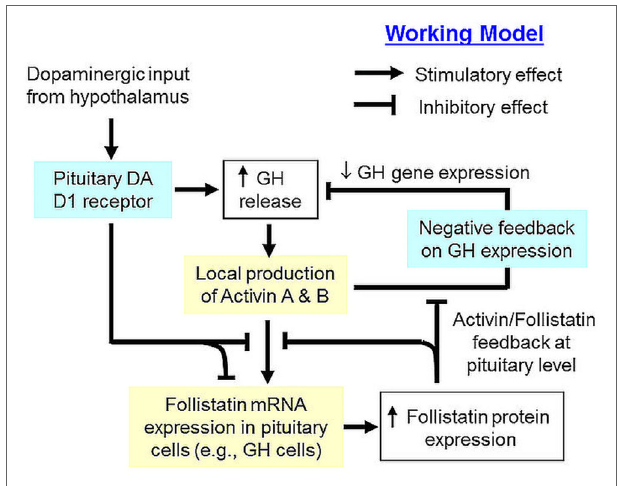
FigUre 8 | Working model of dopaminergic D1 interaction with activin/ follistatin system for growth hormone (GH) regulation in the carp pituitary. In the carp pituitary, local release of GH can induce activin A and B production, which can exert a negative feedback to inhibit GH secretion and GH gene expression. Meanwhile, pituitary expression of follistatin, especially in carp somatotrophs, is also up-regulated by activin A and B, which can trigger a feedback inhibition to suppress the stimulatory effects of activin on follistatin and GH gene expression. Dopaminergic input from the hypothalamus, which is well-documented to stimulate GH release via activation of pituitary dopamine (DA) D1 receptor, can inhibit both basal as well as activin- and GH-induced follistatin expression at pituitary level. This DA D1 action presumably can relief activin feedback on GH regulation from the inhibitory effect of follistatin, which is a major component for signal termination of activin/follistatin system at tissue